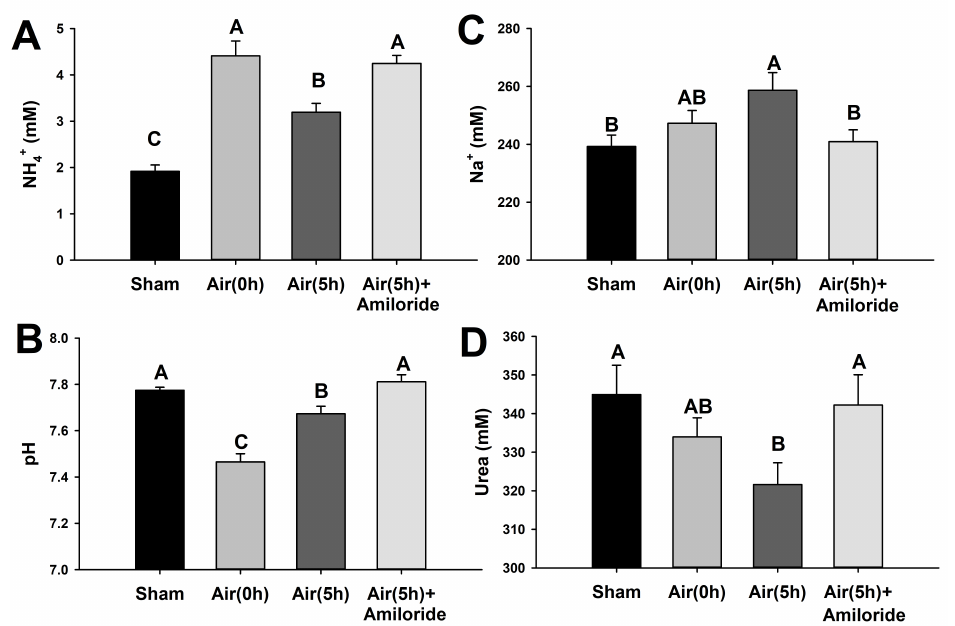
Figure 6. Plasma NH 4+ ( A ), pH ( B ), Na + ( C ), and urea ( D ) in S. canicula exposed to air and in vivo recovered in 100 µ M amiloride for 5 h. The experiment includes an undisturbed-control group named “Sham”, a group sampled immediately after 18 min air exposure “Air(0h)”, and 5 h after recovery in control water “Air(5h)” or containing 100 µ M amiloride “Air(5h)+Amiloride”. Data are expressed as mean ± s.e.m. Different letters indicate significantly different groups ( p < 0.05, n = 12–14). Plasma HCO 3 − , Cl − , Ca 2+ , osmolality, and phosphate after air-exposure and further in vivo recovery with or without amiloride are shown in Table 3. HCO 3 − increased